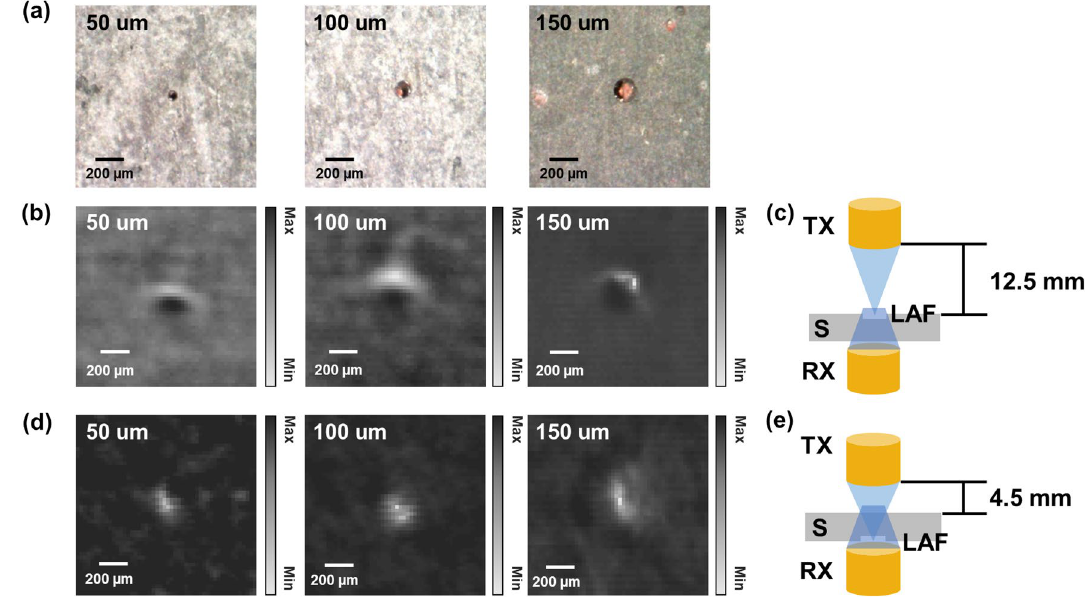
Figure 3. Laser-induced artificial defect (LAF) detection results demonstrating detection of flaws smaller than the lateral resolution of the system. ( a ) The optical microscopic image of the LAFs with a size of 50 μm, 100 μm, and 150 μm. When their position and focus point was at the top surface, ( b ) the US images of the LAFs and ( c ) the diagram. When they were at the bottom, ( d ) the US images of the LAFs and ( e ) the diagram. TX transmitting transducer, RX receiving transducer, S steel sheet, LAF laser-induced artificial flaw. (plotted by: MATLAB R2018a—https:// www. mathw orks. com/ produ cts/ matlab. html, Microsoft PowerPoint 2016—https:// www. micro soft. com/ en- us/ micro soft- 365/ power